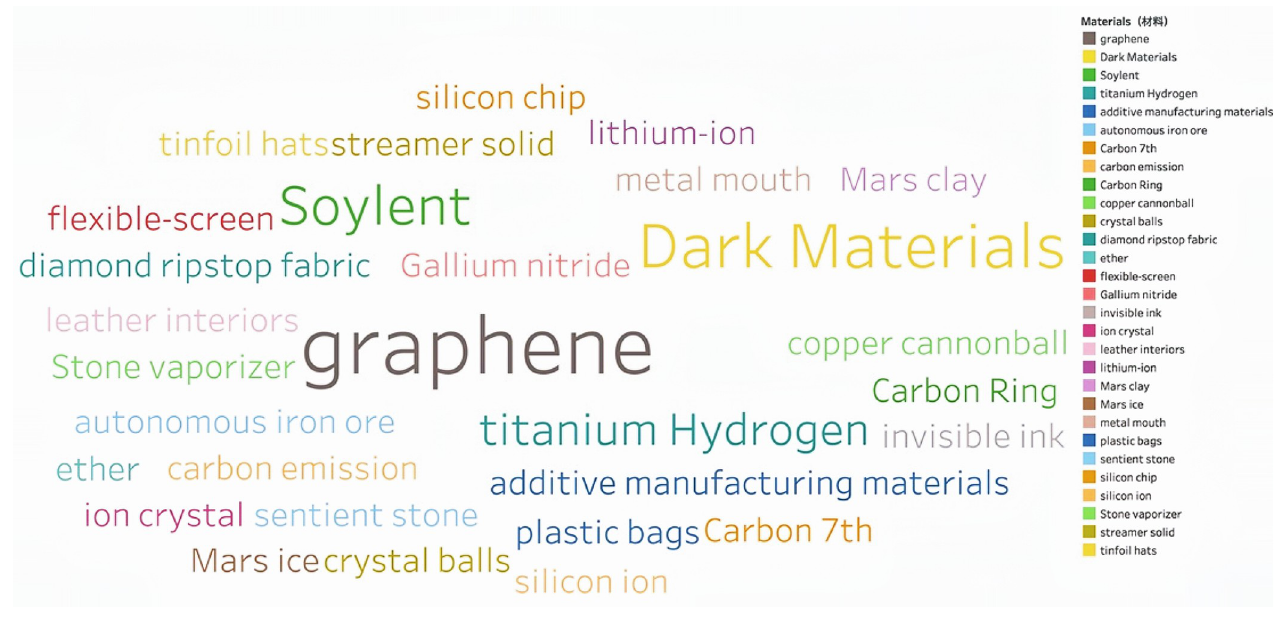
Fig 4. Word cloud diagram in the field of